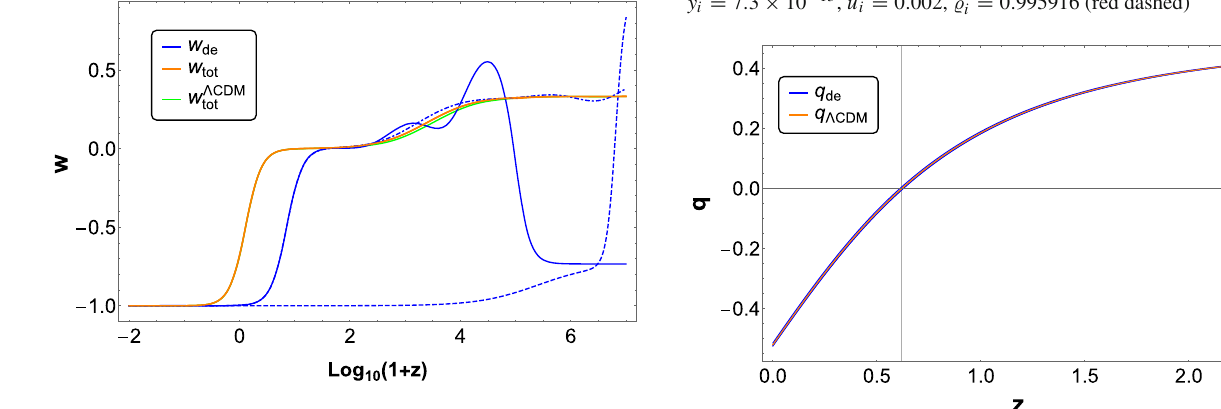
Fig. 7 It is shown the behaviour of the total equation of state w tot (orangeline),theequationofstateofdarkenergy w de (blueline),andthe Fig. 9 We depict the evolution of the deceleration parameter q ( z ) as total equation of state of Λ CDM model (green line) as functions of the a function of the redshift z for the values of parameters s = − 0 . 8, redshift z for s = − 0 . 8, σ = 17 and λ = 0 . 01. Also, for solid, dashed, σ = 17 and λ = 0 . 01, and the same initial conditions used in Fig. 6. and dot-dashed blue lines we have the same initial conditions of Fig. 6. It is also shown the corresponding curve for the deceleration parameter It is obtained the value w de ≈ − 0 . 997 at the current time z = 0, which q Λ CDM ( z ) of the Λ CDM model. It is observed that in all the cases ( 0 ) = − 1 . 028 ± 0 . 032, is consistent with the observational constraint w the cosmological deceleration-acceleration transition redshift happens de from Planck data [7] at z ≈ 0 . 62, very close to the Λ CDM value and then it is consistent with current observational data